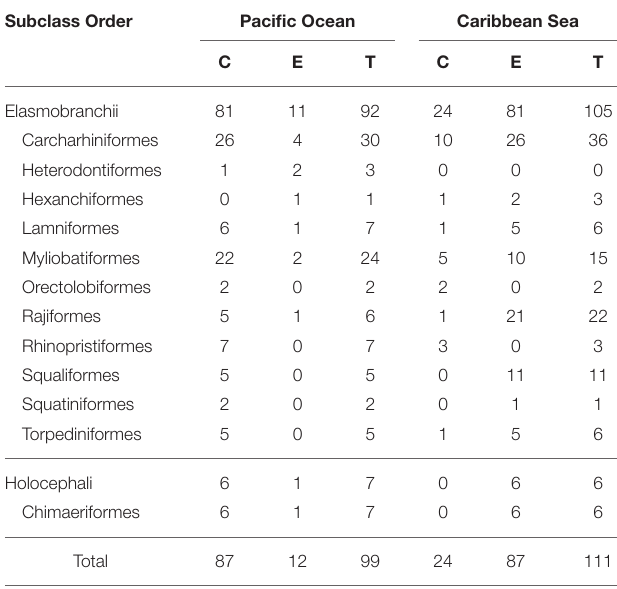
TABLE 1 | Diversity and distributional patterns of Costa Rican